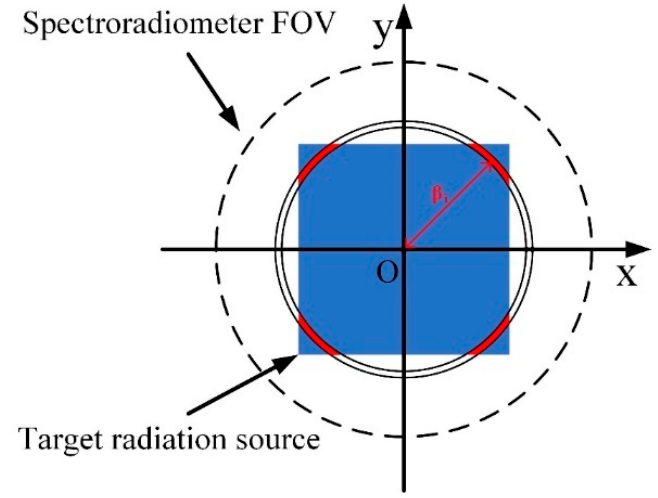
Figure 7. Correction coefficient for the target radiation source in the FOV. From this, it can be seen that every position of the target radiation source in the FOV had a certain correction coefficient. For the calculation of radiation intensity correction, the method of splitting, approximating, summing, and taking the limit was used to derive the formula. The area of the target radiation source was arbitrarily divided into n area elements. For the FOV area with position coordinates ( ε j, µ j ), the area element of this area was ∆ σ j and the radiation intensity was: